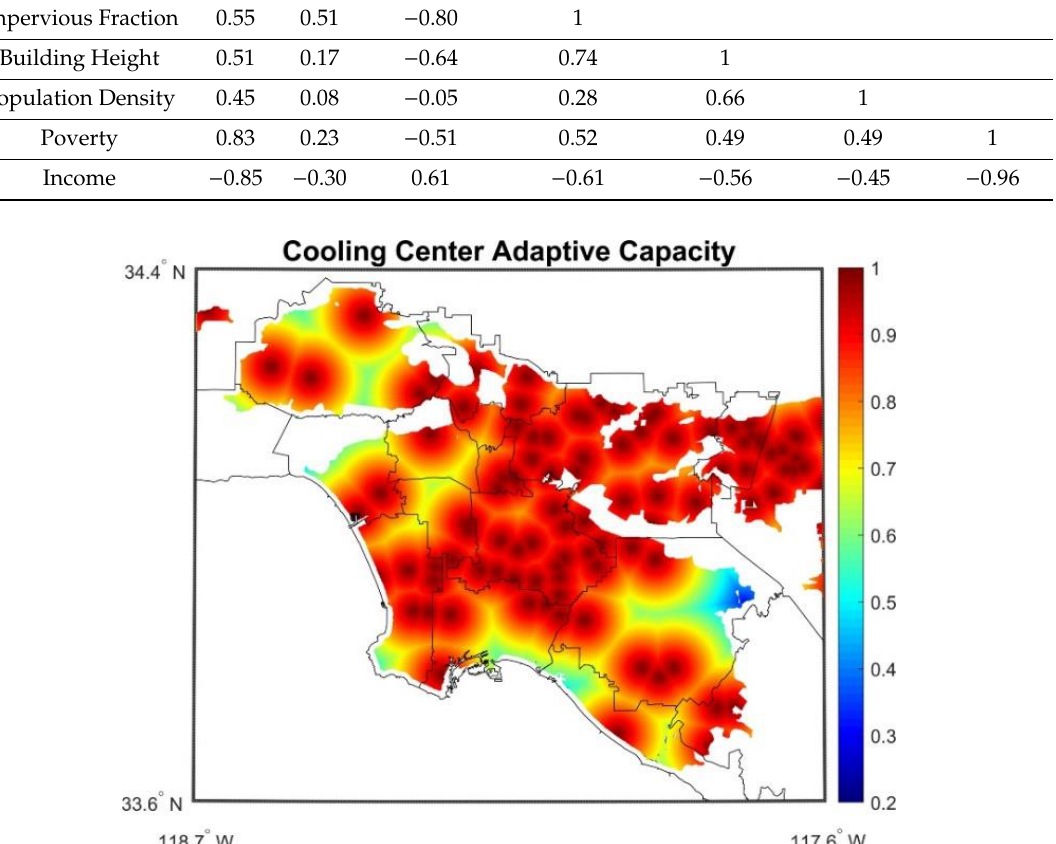
Figure A1. Cooling center locations represented as an adaptive capacity variable by calculating radial distances from each pixel on the LA study region grid to the nearest cooling center. Higher values represent areas nearest to a cooling center, corresponding to a higher adaptive capacity, i.e., a lower vulnerability.